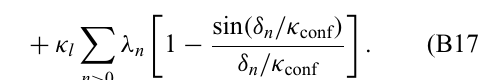
FIG. 15. Bit-flip error probabilities of idling cat qubits con- fined by combined Kerr (top) and TPE (bottom) schemes at working points K /κ 2 = 3 and g 2 /κ 2 = 20. The cat qubit is sub- ject to single-photon loss at rate κ 1 /κ 2 = 10 − 3 , as well as pure dephasing at rate κ φ /κ 2 = 10 − 5 (solid lines) or thermal excita- tions at rate κ 1 n th /κ 2 = 10 − 5 (dashed lines). The idling time on the horizontal axis is given in units of 1 /κ conf to show a clear transition to the single exponential behavior of the dynamics at around T idle × κ conf (cid:2)